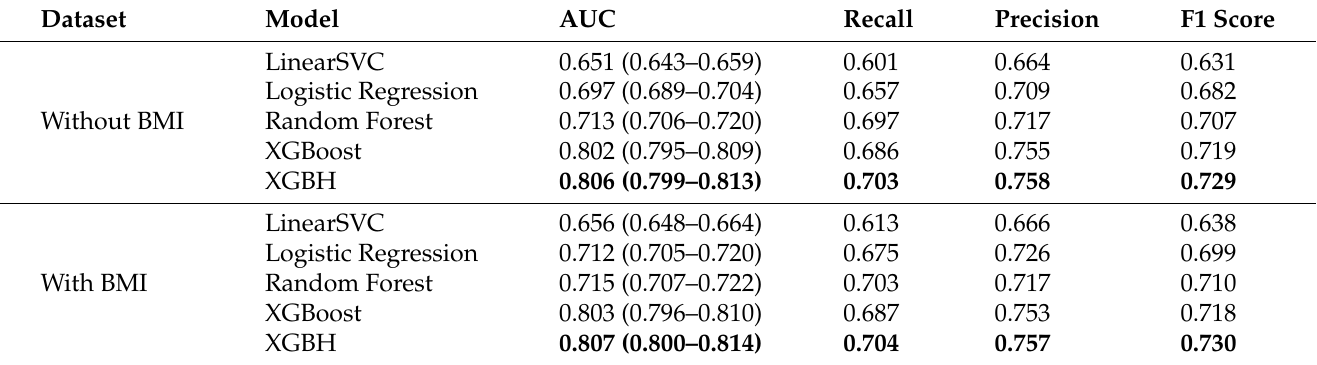
Table 2. Characteristics of the